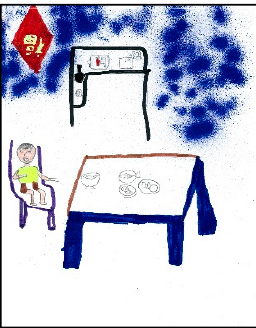
Figure 1. An unsuccessful case of using different painting materials.